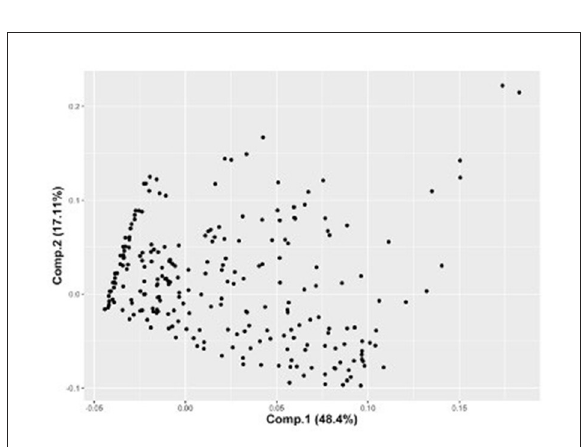
FIGURE3 Score plot of dogs on the first (PC 1) and second (PC 2) principal components, with the increase of